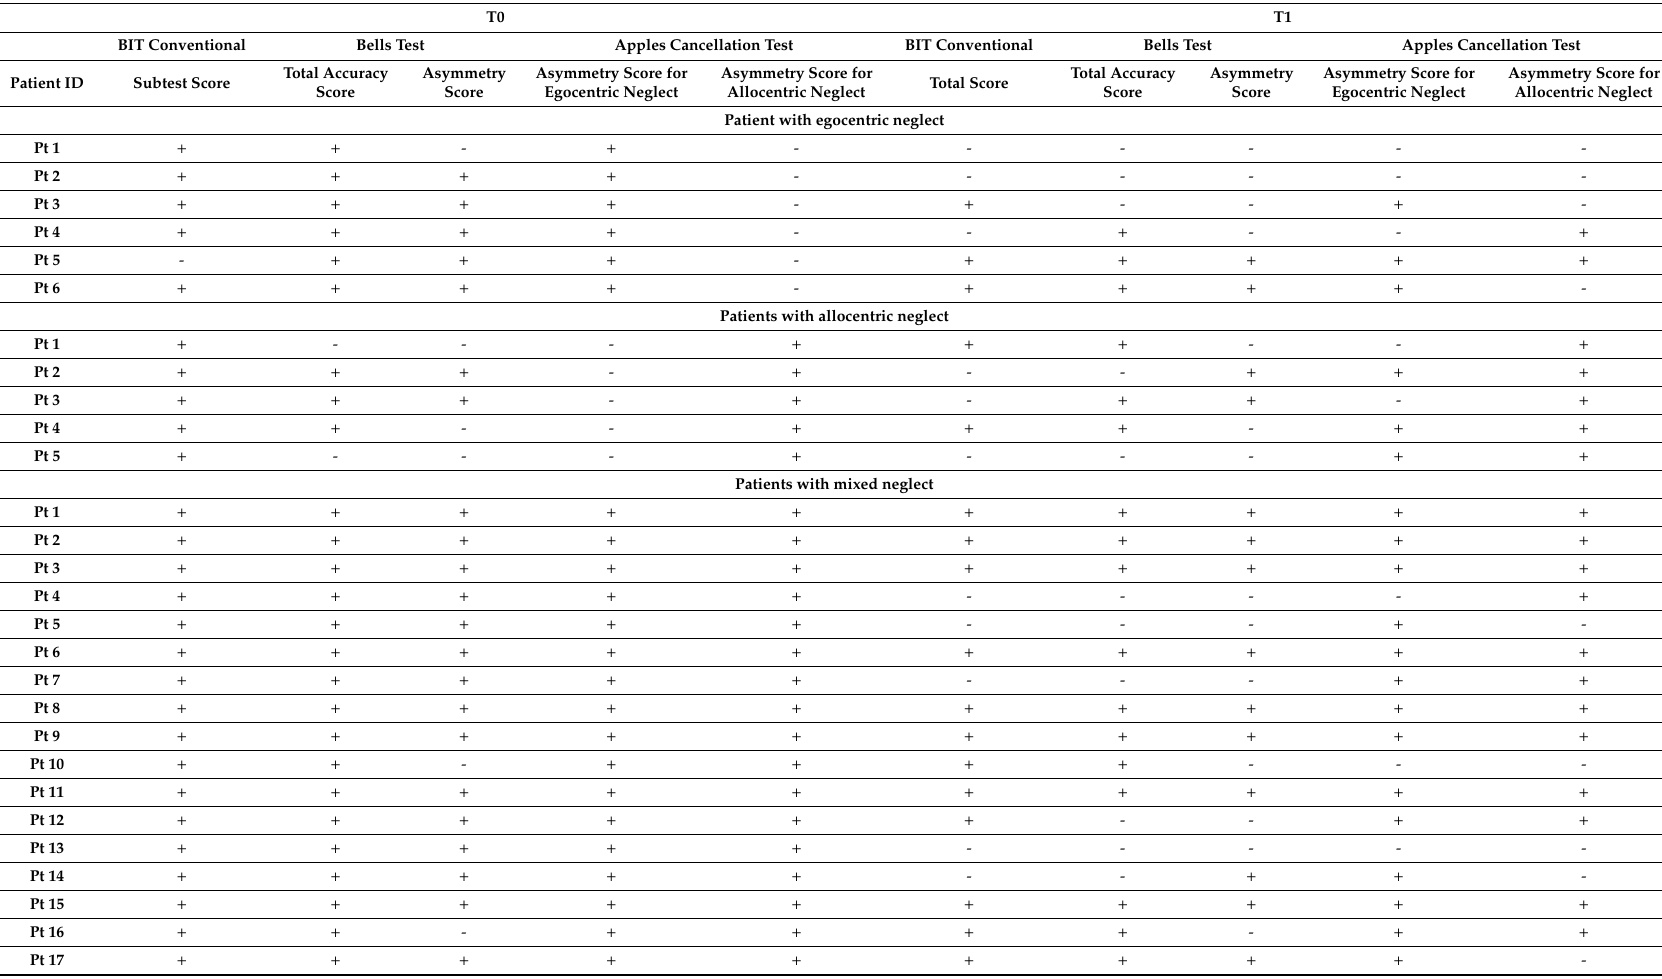
Table 1. Individual performance in the Behavioural Inattention Test (BIT) conventional, in the Bells test, and in the Apples Cancellation test before (T 0 ) and after (T 1 ) the PA training. A + sign indicates a pathological performance according to the norms (in the case of BIT, a + indicates a low performance in at least two subtests of the scale; a – sign indicates a performance within normal